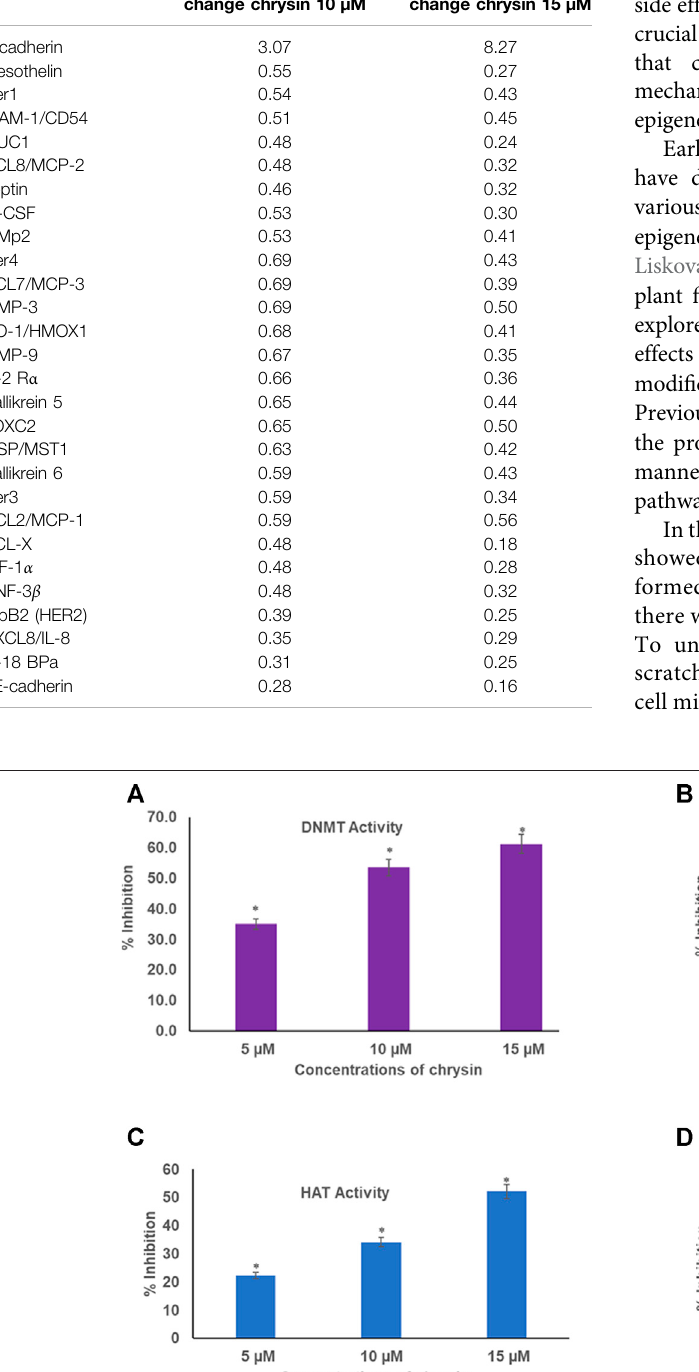
TABLE 2 | Expression of proteins involved in migration and in fl ammation. The values are taken as mean of three experiments ± SD ( p ≤ 0.05). Oncogene proteins Fold Fold change chrysin 10 µM change chrysin 15 µM